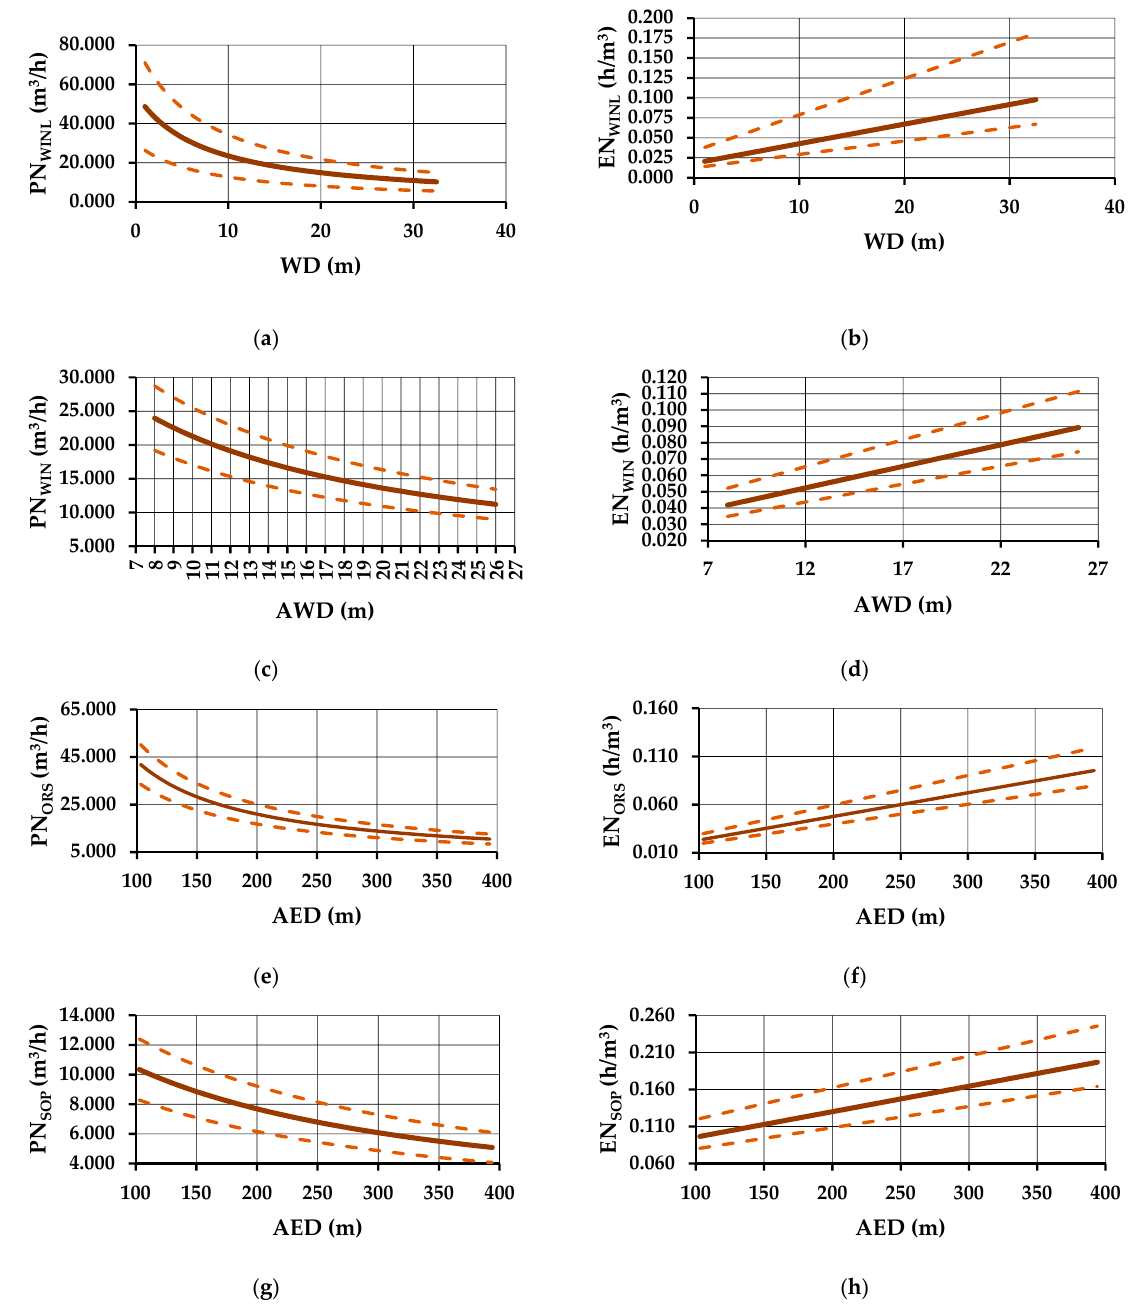
Figure 6. Efficiency and productivity models developed by taking as a reference the mean and standard deviation values of log (LV) and payload (PV) volumes and the ranges of operational distances: ( a ) variation in net productivity of log-based winching; ( b ) variation in net efficiency of log-based winching; ( c ) variation in net productivity of winching; ( d ) variation in net efficiency of winching; ( e ) variation in net productivity of on-road skidding; ( f ) variation in net efficiency of on-road skidding; ( g ) variation in net productivity of skidding operations; ( h ) variation in net efficiency of skidding operations. Note: light brown dashed lines stand for productivity and efficiency computed by using mean ± standard deviations of the log ( a , b ) and payload volume ( c – h ), dark brown continuous lines stand for productivity and efficiency computed by using mean values of the log ( a , b ) and payload volume ( c – h ); models from ( c – f ) were built using the median value of the number of logs (NL = 5), and models from ( g , h ) were built by using the median values of NL (5) and average winching distance (AWD = 13.15